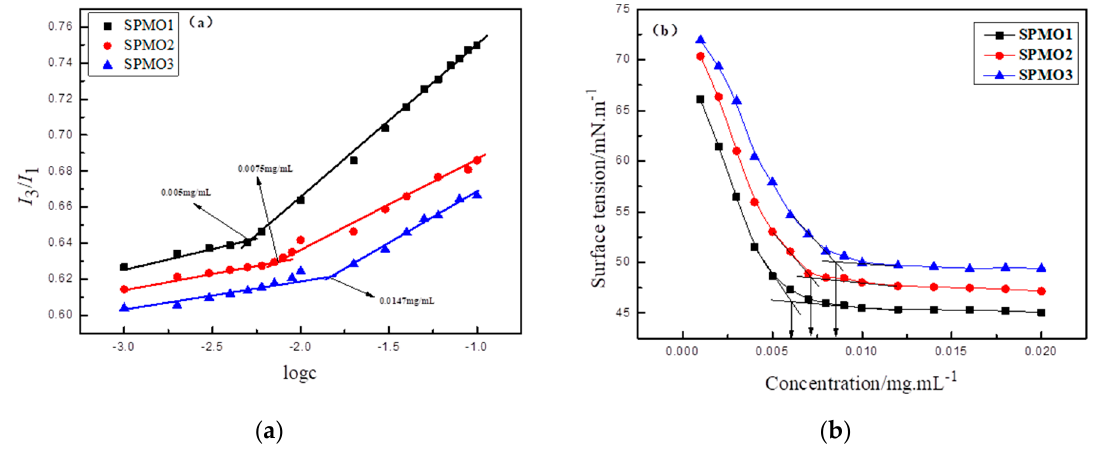
Figure 6. The critical micelle concentration (CMC) of the triblock copolymers with different polymerization degrees (DP) determined by ( a ) the emission spectra or ( b ) surface tension meter.